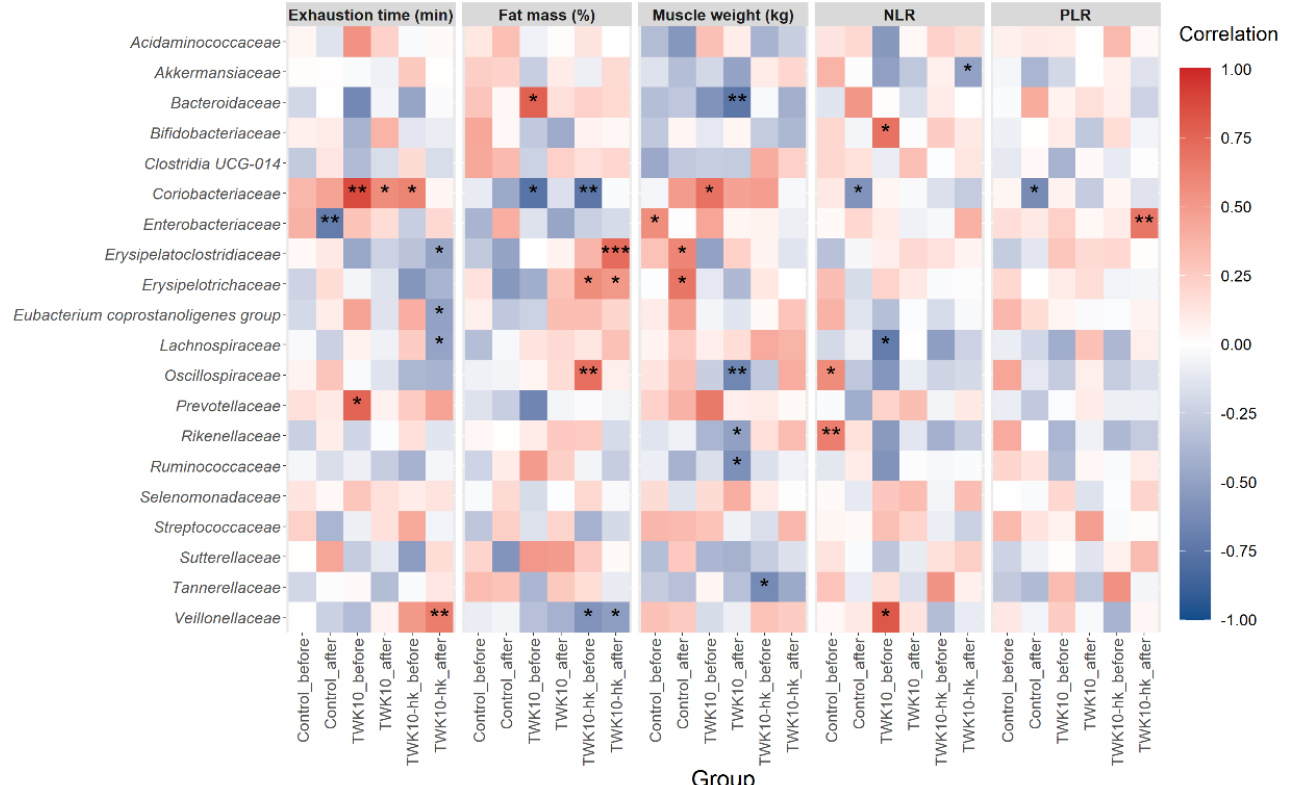
Figure 6. Heatmap of Spearman’s correlation analysis between gut microbiota and functional parameters in subjects who received viable or heat-killed TWK10 administration. Spearman’s correlation values were calculated between the abundances of the top 20 most abundant bacterial families and phenotypic changes following administration of viable or heat-killed TWK10. Red squares, positive correlations; blue squares, negative correlations. * P < 0.05, ** P < 0.01, *** P < 0.001.